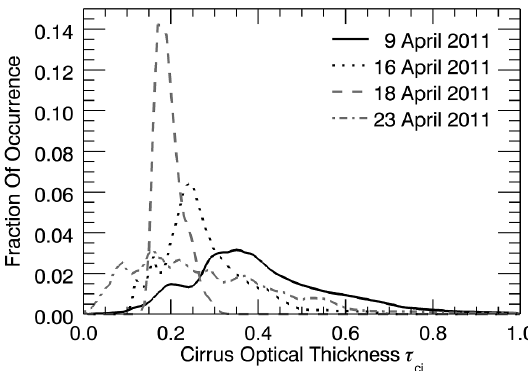
Fig.14: Normalizedhistogramsof τ ci foreachofthefourconsideredmeasurementdays. Thebinsizeis0.01unitsofcirrus Fig. 14. Normalised histograms of τ ci for each of the four consid- opticalthickness τ ci . ered measurement days. The bin size is 0.01 units of cirrus optical thickness τ ci